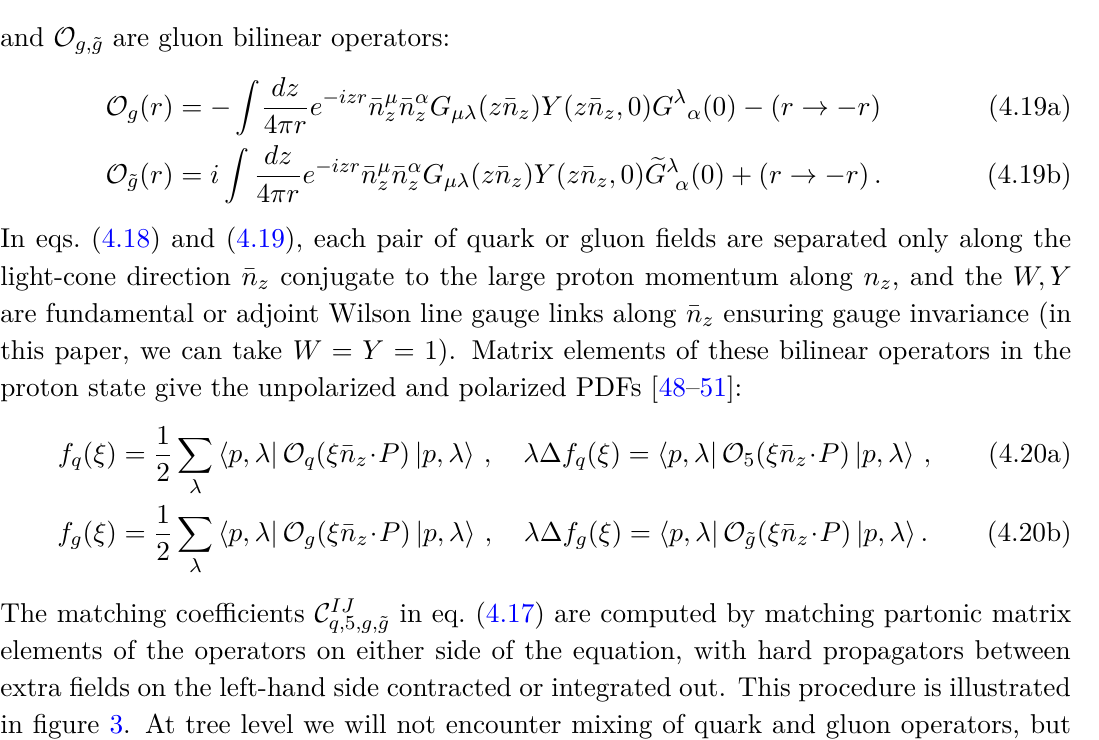
or O give (un)polarized q, 5 g, ˜ g